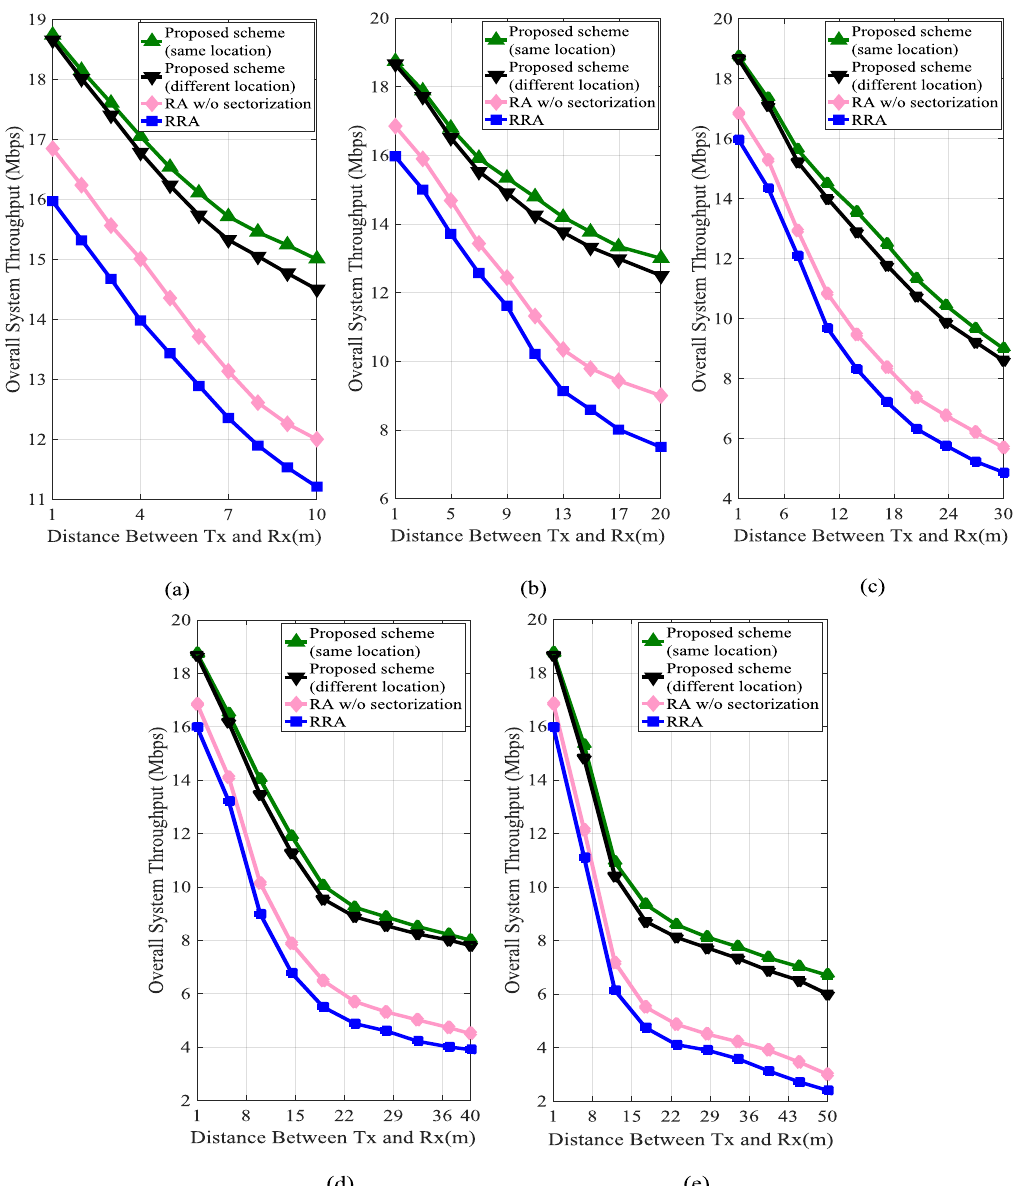
Figure 9. Overall system throughput with varying distance between D2D Tx and Rx. ( a ) 1–10 m, ( b ) 1–20 m, ( c ) 1–30 m, ( d ) 1–40 m, and ( e ) 1–50 m. The average system spectral efficiency vs. CDF when both the D2D Tx and Rx are located in the same and different sections of the cell with varying number of D2D pairs as compared with cellular users are plotted in Figure 10a. As expected, the RRA scheme achieves minimum spectral efficiency.